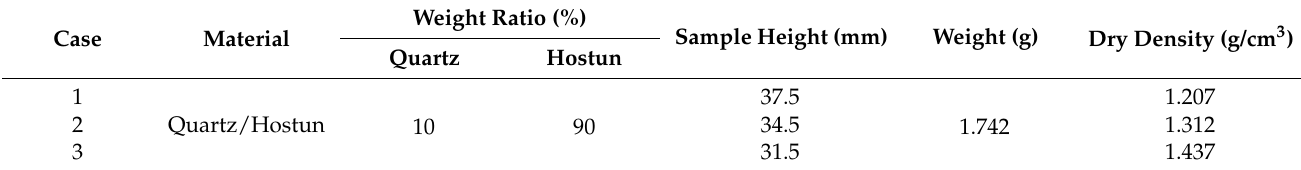
Figure 13. ( a ) Mixture of 10% quartz and 90% Hostun sand; ( b ) typical sample for micro-CT analysis. Table 1. Schedules of the various samples for micro-CT analysis for different